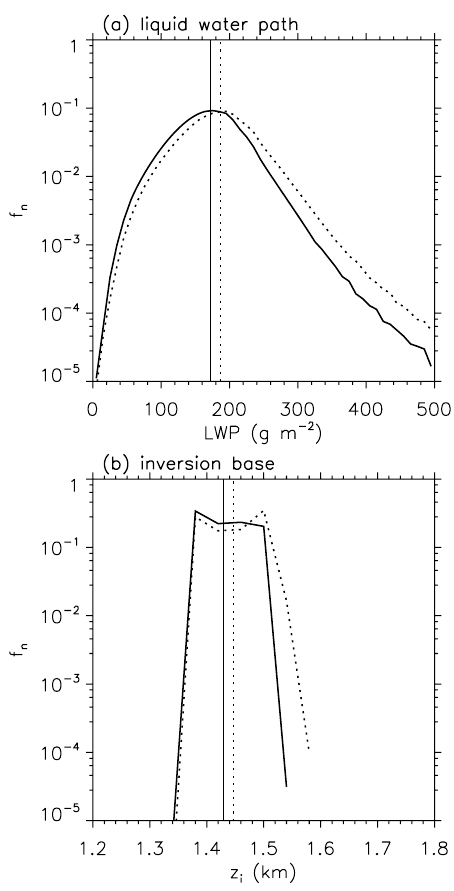
Fig. 9. Normalized frequency distributions of (a) liquid water path, (b) inversion base height over 8h for experiments CTRL (solid lines) and UPSW (dotted lines) with the0 corresponding vertical lines indicating median